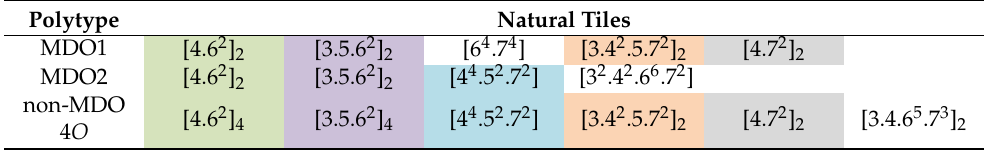
Table 1. The natural tiles in the MT -frameworks of the polytypes of compounds with the general